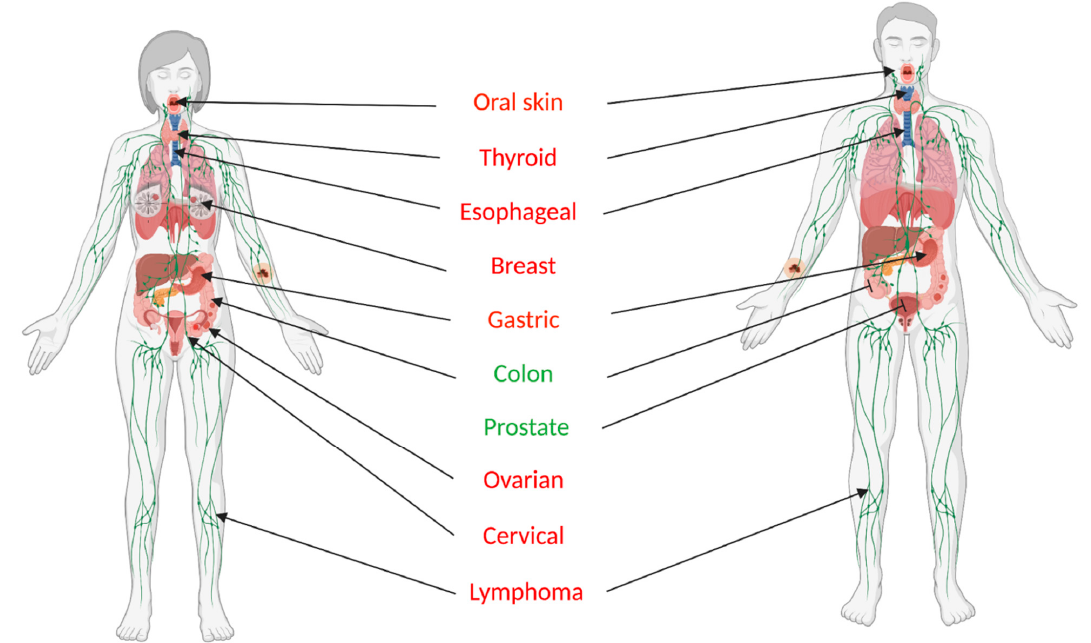
Figure 1. The dual role of galectin-7 in cancer. In most cancer types, overexpression of galectin-7 is associated with and/or promotes cancer progression. For some types of cancer, such as colon cancer and prostate cancer (in green), expression of galectin-7 is rather associated with an anti-tumor role.